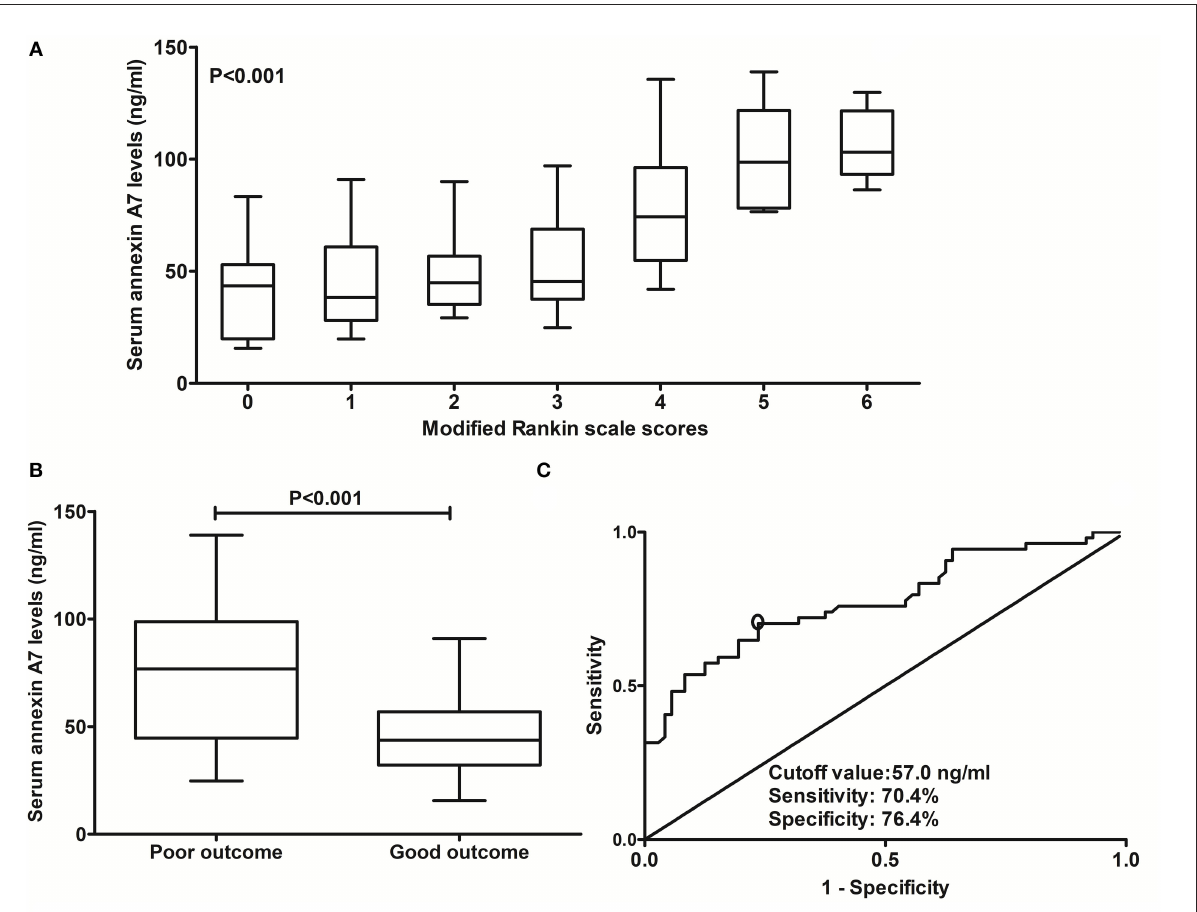
FIGURE5 Relationship between serum annexin A7 levels and prognosis at 90 days after intracerebral hemorrhage. (A) Relationship between serum annexin A7 levels and modified Rankin Scale score among patients with acute intracerebral hemorrhage. (B) Comparison of serum annexin A7 levels between patients with poor outcome and those with a good outcome. (C) Analysis with respect to the predictive value of serum annexin A7 levels for 90-day poor outcome after acute intracerebral hemorrhage. Comparison of data was done among multiple groups using the Kruskal–Wallis H test. There was a significant elevation of serum annexin A7 levels after hemorrhagic stroke by modified Rankin Scale scores ( P < 0.001). Serum annexin A7 levels were dramatically higher in patients with poor outcome than in those with good outcome